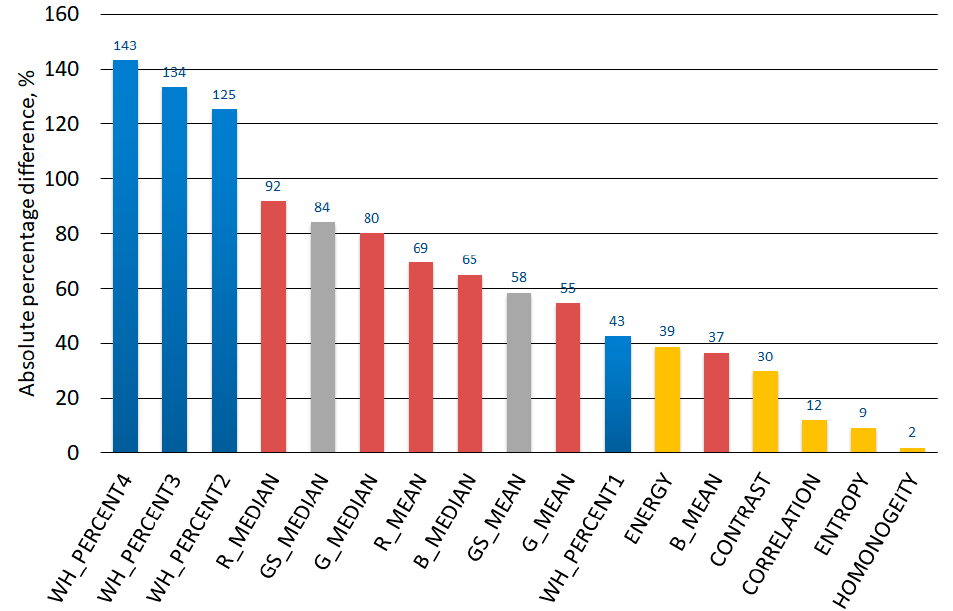
Figure 10. Absolute percentage differences in the values of the analyzed parameters of color and texture for the images of the material obtained under favorable and unfavorable composting conditions (blue color—parameters for a binarized image, red color—parameters for an RGB model image, gray color—parameters for a grayscale image, yellow color—texture parameters for a grayscale image).